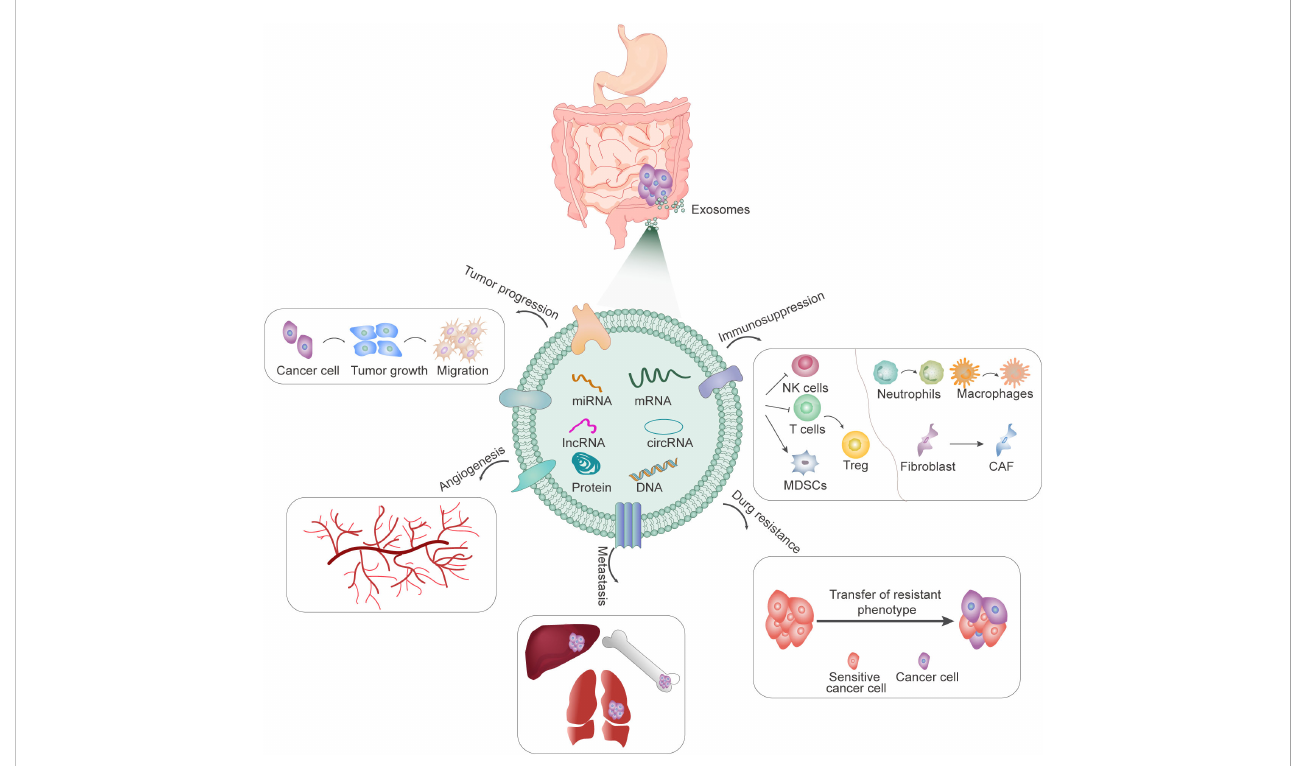
FIGURE 1 The role of exosomes in gastrointestinal